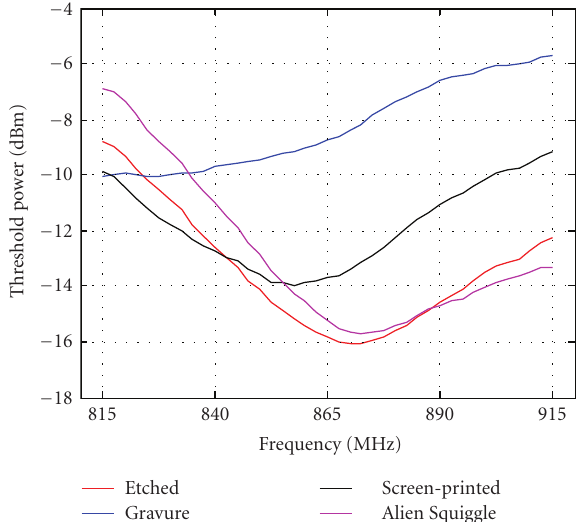
Figure 8: Measured threshold power versus frequency.